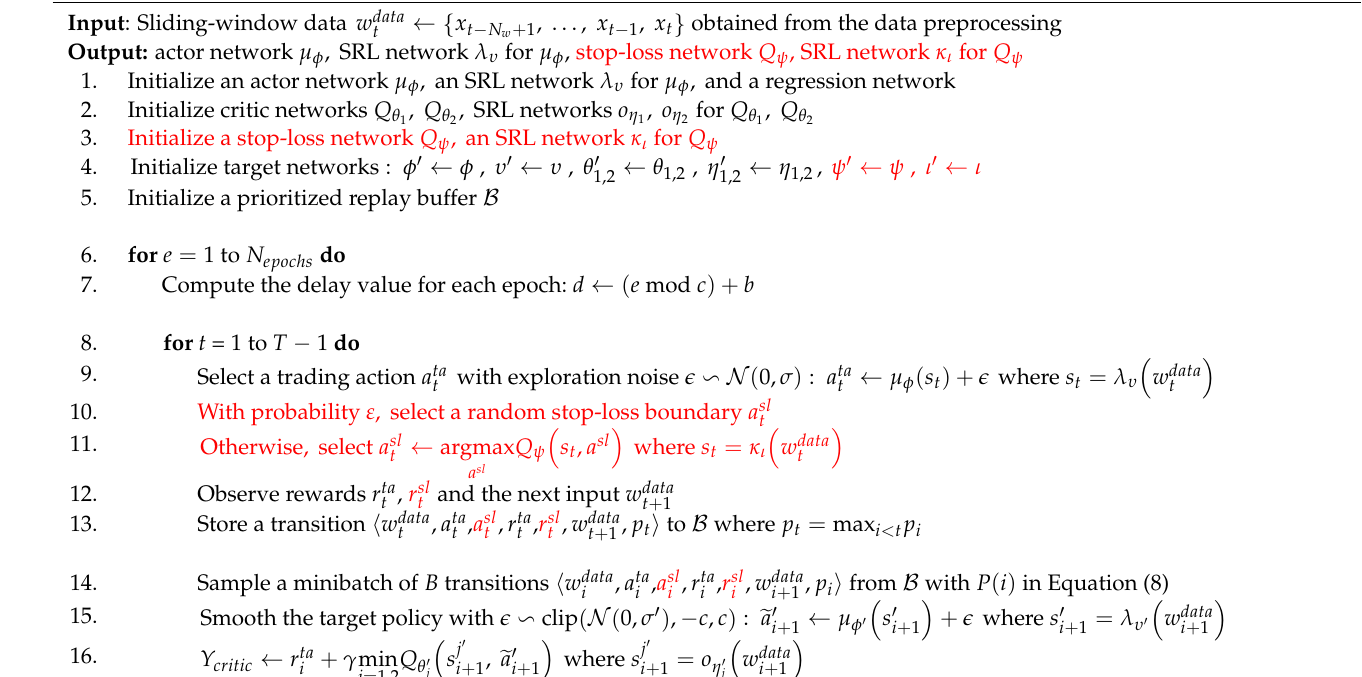
Figure 7. To support discrete stop-loss boundaries, a softmax layer is used as the output layer of the stop-loss network. An action a sl is selected using the ε -greedy strategy (lines 10 t and 11). The target value Y sl is computed as in the DDQN, and then, the stop-loss network is updated using Y sl (lines 20 and 21). When the stop-loss network is updated, the SRL network κ ι is also updated by backpropagation. Algorithm 1. The hybrid reinforcement learning algorithm of